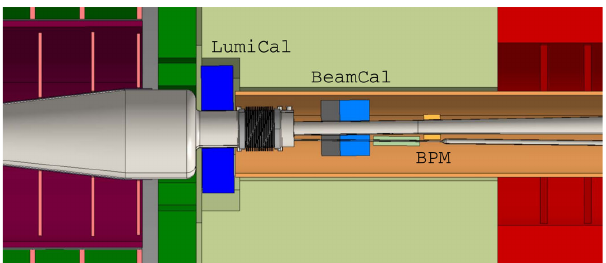
FIG. 3. The forward region of the CLIC detector. The inter- action point is to the left, and the spent beam and the beam- strahlung photons leave the detector through the outgoing beam pipe. The LumiCal is a dedicated detector for precise luminosity measurements from Bhabha events, whereas the purpose of the BeamCal is to provide a quick luminosity estimation by meas- uring incoherent electron-positron